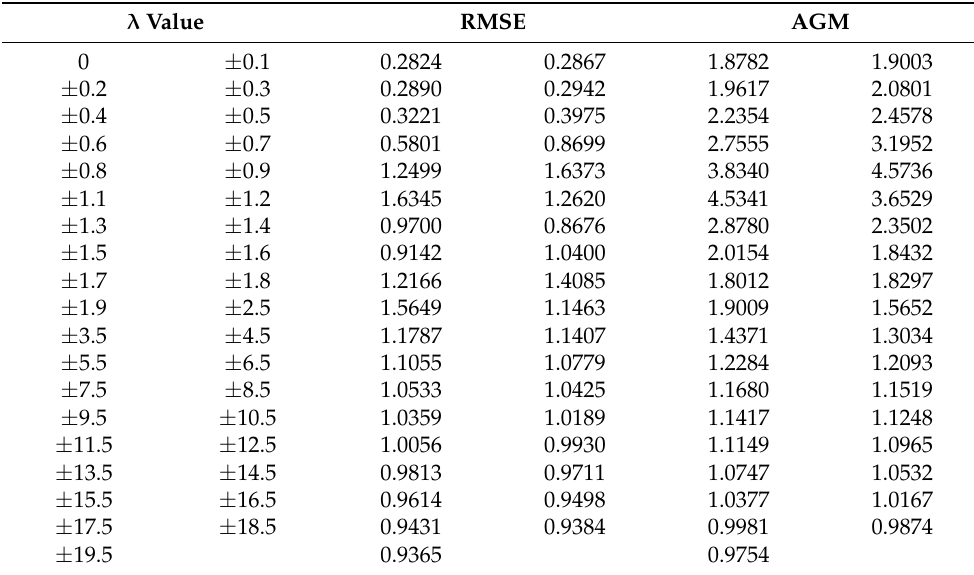
Table A2. Data set of RMSE and AGM of reconstructed Shepp–Logan images by basic filters with different λ